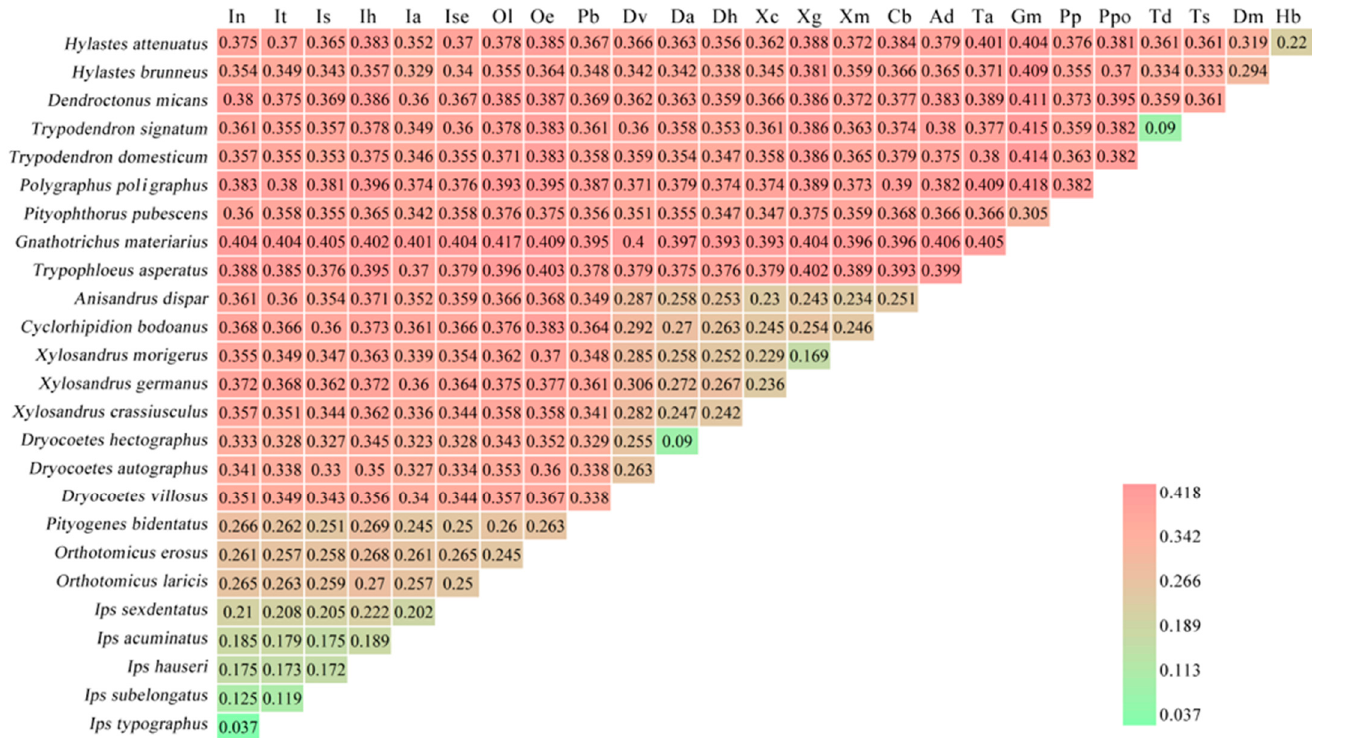
Figure 4. Genetic distance of bark beetles in Scolytinae. Species names on the horizontal axis are abbreviated by the first letter of the two words of the species name, and one letter is added to the second word of the species name if the two letters are the same.